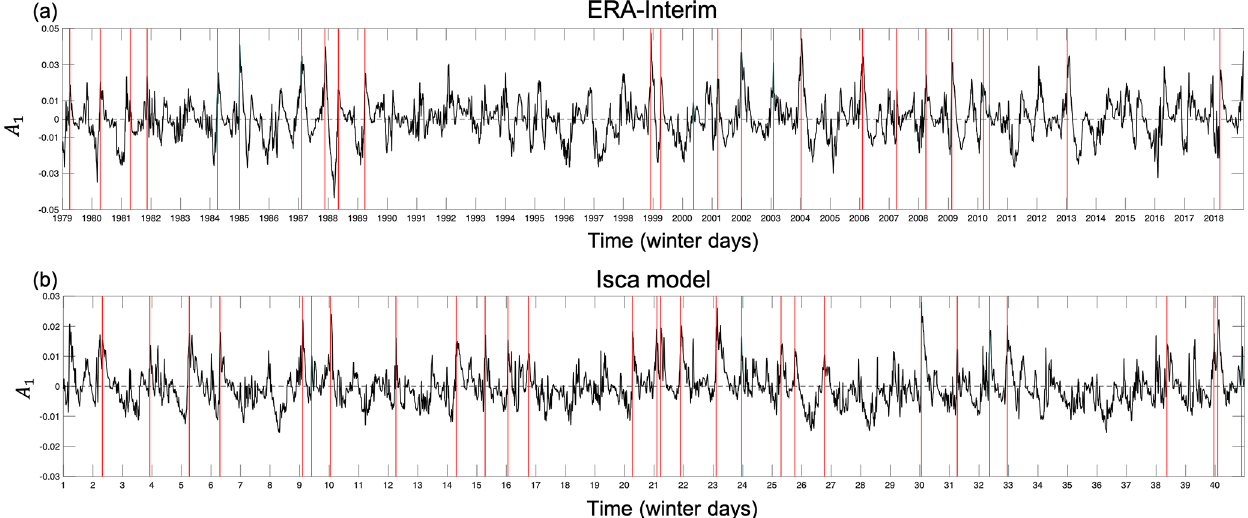
Figure 2. The PC time series ( A 1 ) of all winter days corresponding to the first EOF mode E 1 using (a) ERA-Interim reanalysis data and (b) Isca model output data. (a) All winter days (from October to April) are shown and in (b) only the winter days for the first 40 years are shown as an example. The PC time series for winter days of the remaining 90 years in the Isca model can be seen in Fig. C2. The red vertical lines indicate the onset dates of SSW